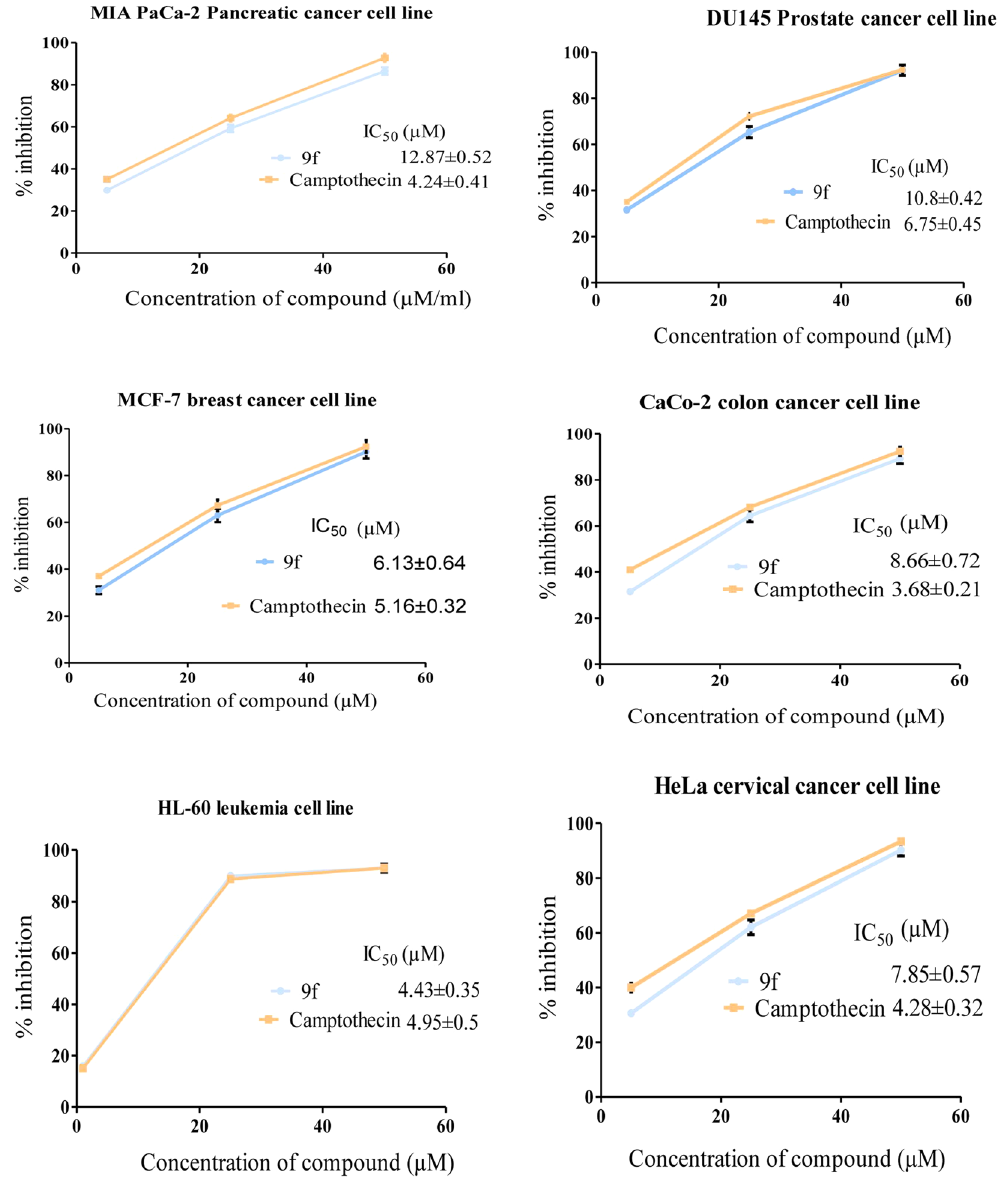
Figure 4. Antiproliferative activity of 9f on cancer cell lines. Antiproliferative effect of 9f on Mia PaCa-2 pancreatic, DU145 prostate, MCF-7 breast CaCo-2 colon cancer, HL-60 leukemia and HeLa cervical cancer cell lines is presented in dose-dependent manner. IC 50 values of the 9f and camptothecin (positive control) are depicted in the figure. Data are presented as the mean ± SEM of three independent